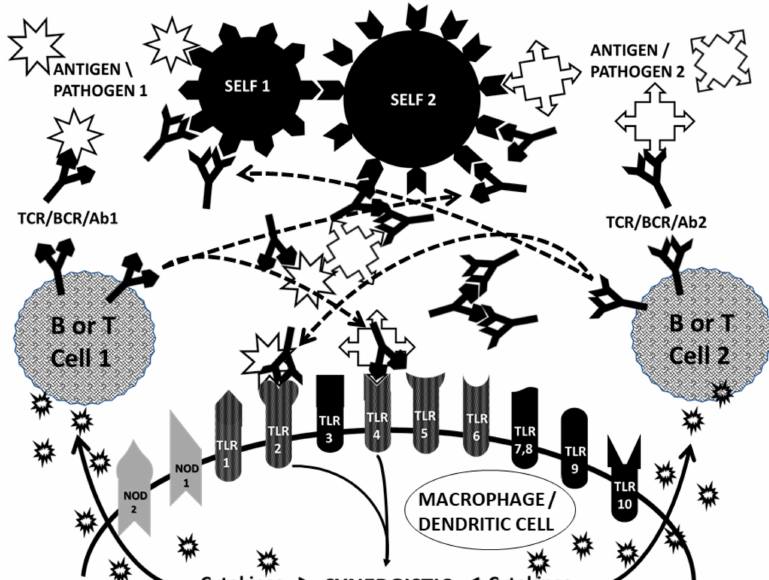
Figure 10. Schematic diagram of the complementary antigen theory (CAT) showing how it integrates (Figures 6 and 7) synergistic TLR / NOD activation to create a chronic inflammatory environment supporting chronic autoimmune disease. Complementary antigens induce two sets of B or T cells to produce complementary immune responses (here illustrated as antibodies for simplicity) that mimic the antigenicity of the initiating antigens. The antigens and antibodies form circulating immune complexes that bind to target tissues mimicked by the antigens resulting in complement activation and cellular destruction. Since the antibodies mimic the antigens, they activate the same sets of TLR / NOD as did the initiating antigens (here illustrated by binding to TLR2 and TLR4), producing the same synergistic support of continued B (or T) cell activation on a chronic basis. In this way, complementary antigens break tolerance, induce chronic inflammation within the innate immune system by means of activating complementary, synergistic TLR / NOD and the adaptive immune system continues to drive its own upregulation through stimulation of innate